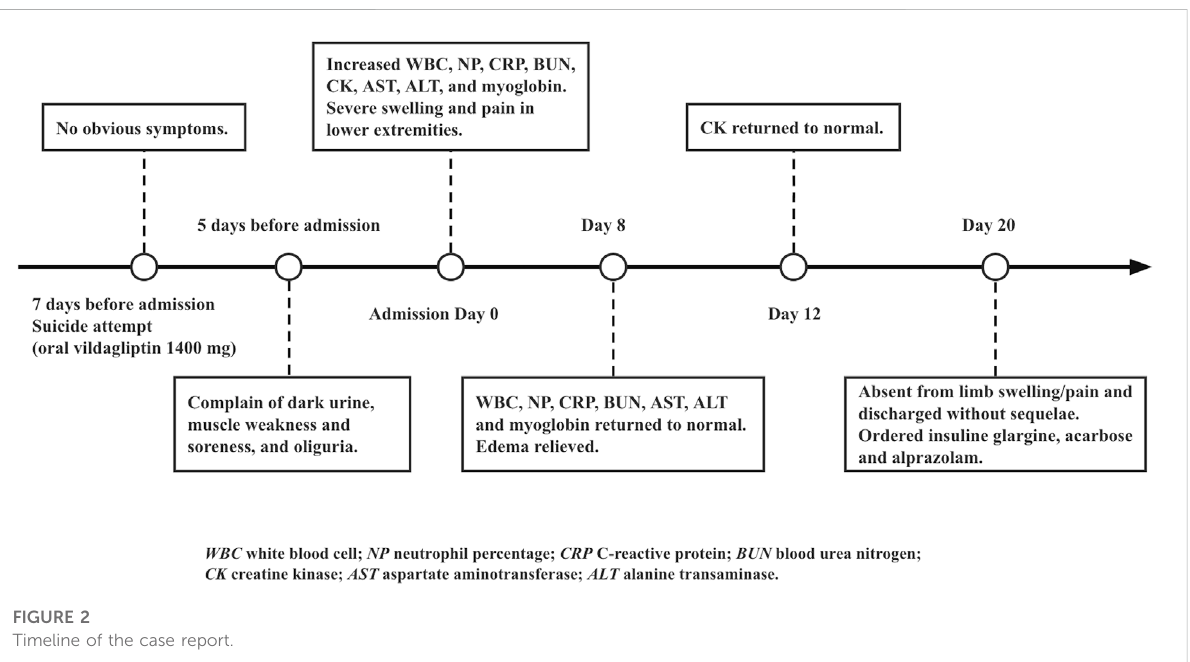
FIGURE 2 Timeline of the case